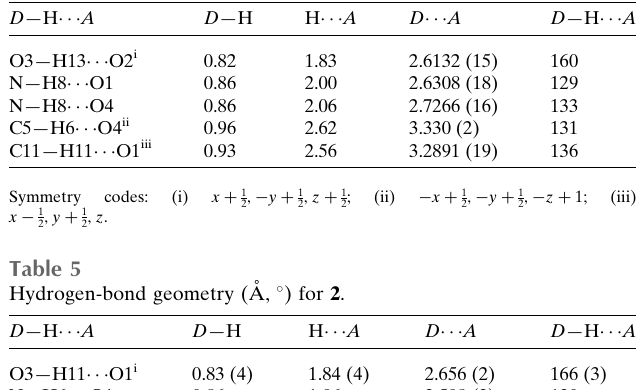
Table 4 Hydrogen-bond geometry (A˚ , (cid:3) ) for 1 .